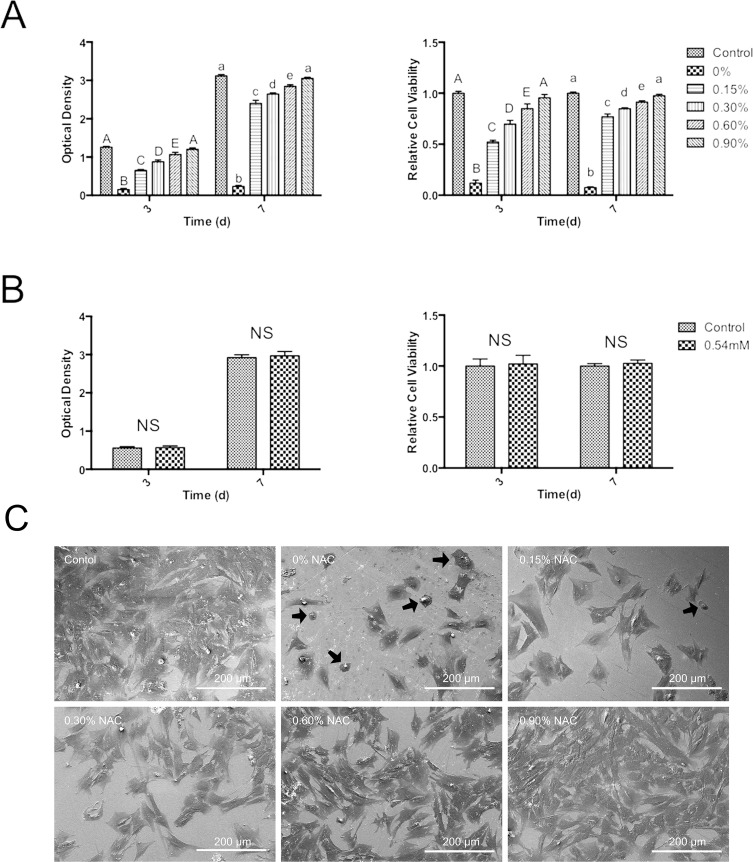
Cytotoxicity of PMMA resin with or without NAC.Data are presented as the mean ± SD of three independent experiments performed in quintuplicates. (A) Effects of the extract of PMMA resin with or without NAC on the viability of HDPCs at day 3 and day 7. For each tested time period, values with different superscripts are significantly different from each other (One-way ANOVA, p < 0.05). (B) Effects of 0.54 mM NAC on the viability of HDPCs at day 3 and day 7. Values with different superscripts are significantly different from each other (One-way ANOVA, p < 0.05). NS, not significant between the control group and the experimental group. (C) Typical SEM pictures showing cell attachment and morphology on top of PMMA resins with or without NAC. The cells with round or collapsed appearances were observed in subgroups containing no or 0.15 wt.% NAC (arrows).